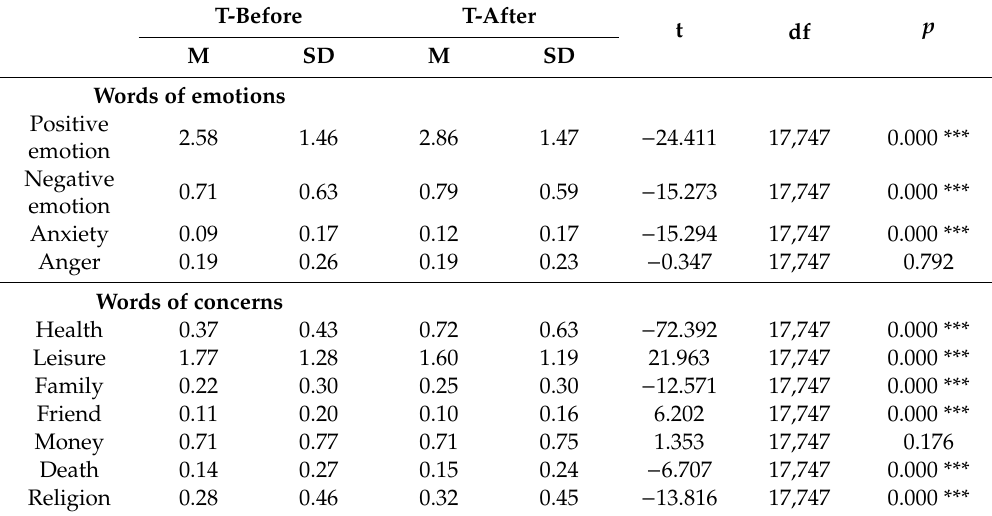
Table 2. Word frequency analysis before and after 20